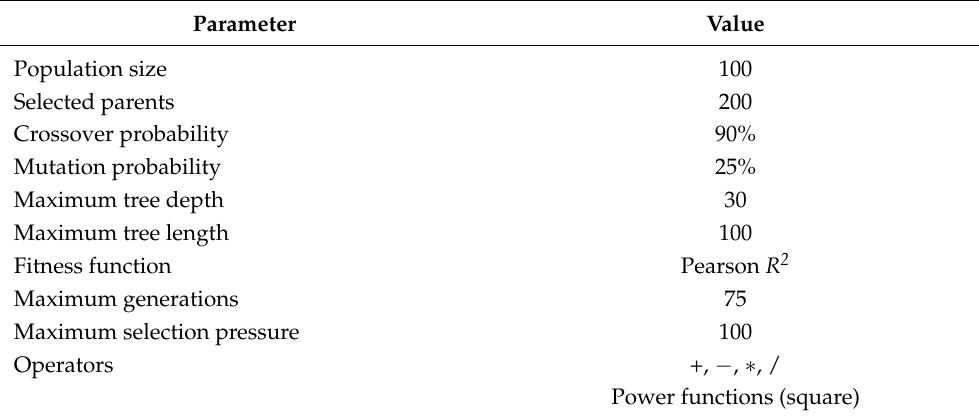
Table 5. OSGA parameter